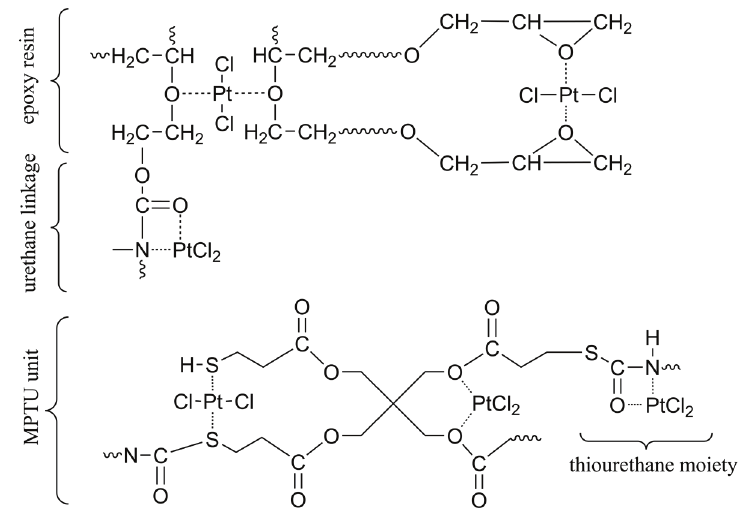
Figure 3: Possible modes of coordination of Pt(II) complex by DER/MPTU